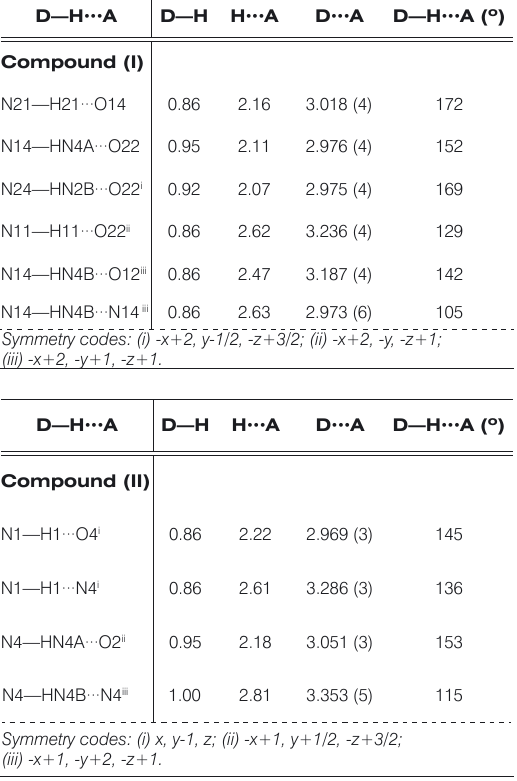
remaining hydrogen bonds (Table 3 ) to form infinite [011] layers (Fig. 2). Table 3. Hydrogen bonds (Å) structure data in (I) and (II)